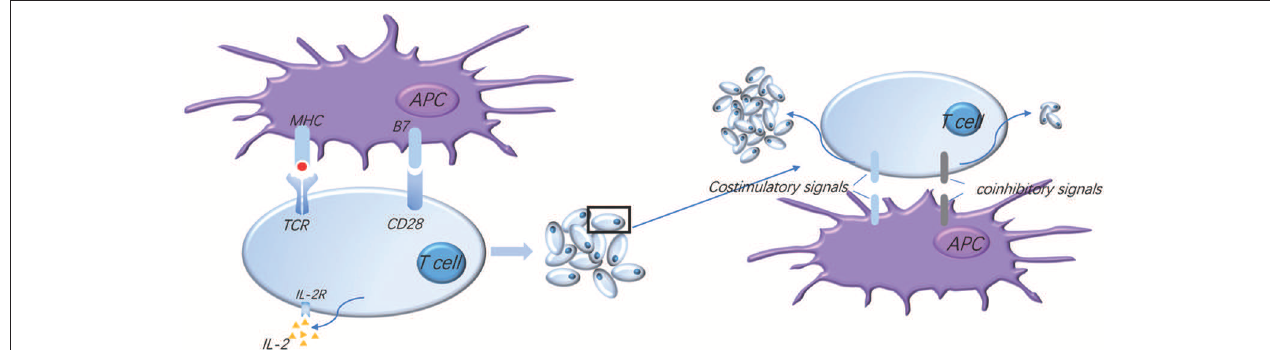
FIGURE 1 | Normal activation of T cells requires costimulatory and coinhibitory signal molecules. The activation of T cells means firstly that T cells recognize the antigen presented by APC, and secondly that the costimulatory molecule B7 on the APC surface binds to the CD28 presenting on the surface of T cells to provide the second signal for the activation of T cells, which makes T cells secrete IL-2 and express high levels of IL-2R, thus promoting the proliferation and activation of T cells. Meanwhile, a variety of costimulatory and coinhibitory molecules are expressed successively on the surface of T cells: costimulatory signals further promote T cell proliferation and coinhibitory signals limit T cell activation and proliferation, which regulate T cell moderate activation accurately, effectively start the immune response, and prevent excessive immune damage to the tissue.